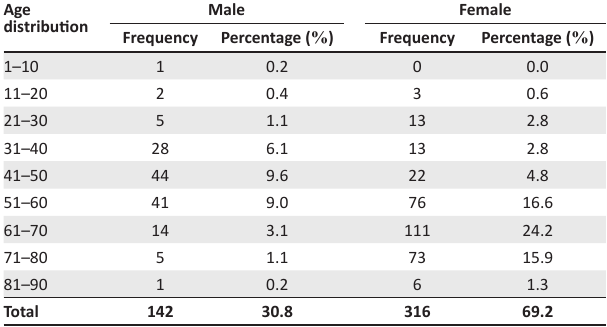
TABLE 1a: Frequency table for the demography of radiation oncology